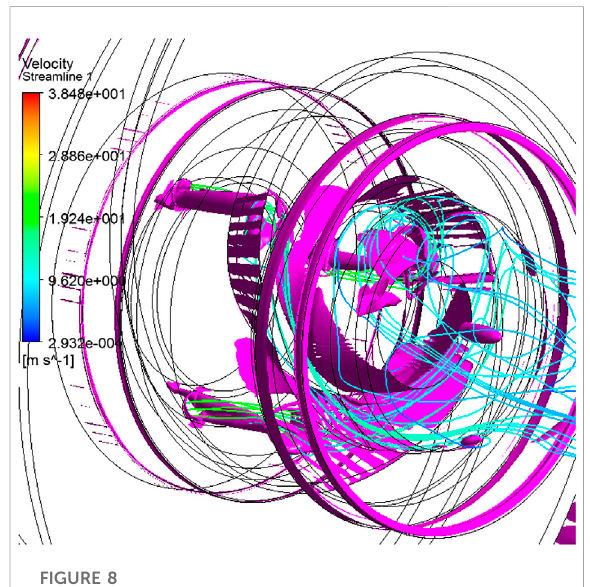
Vortex structures identi fi ed by Q criterion at three fl ow